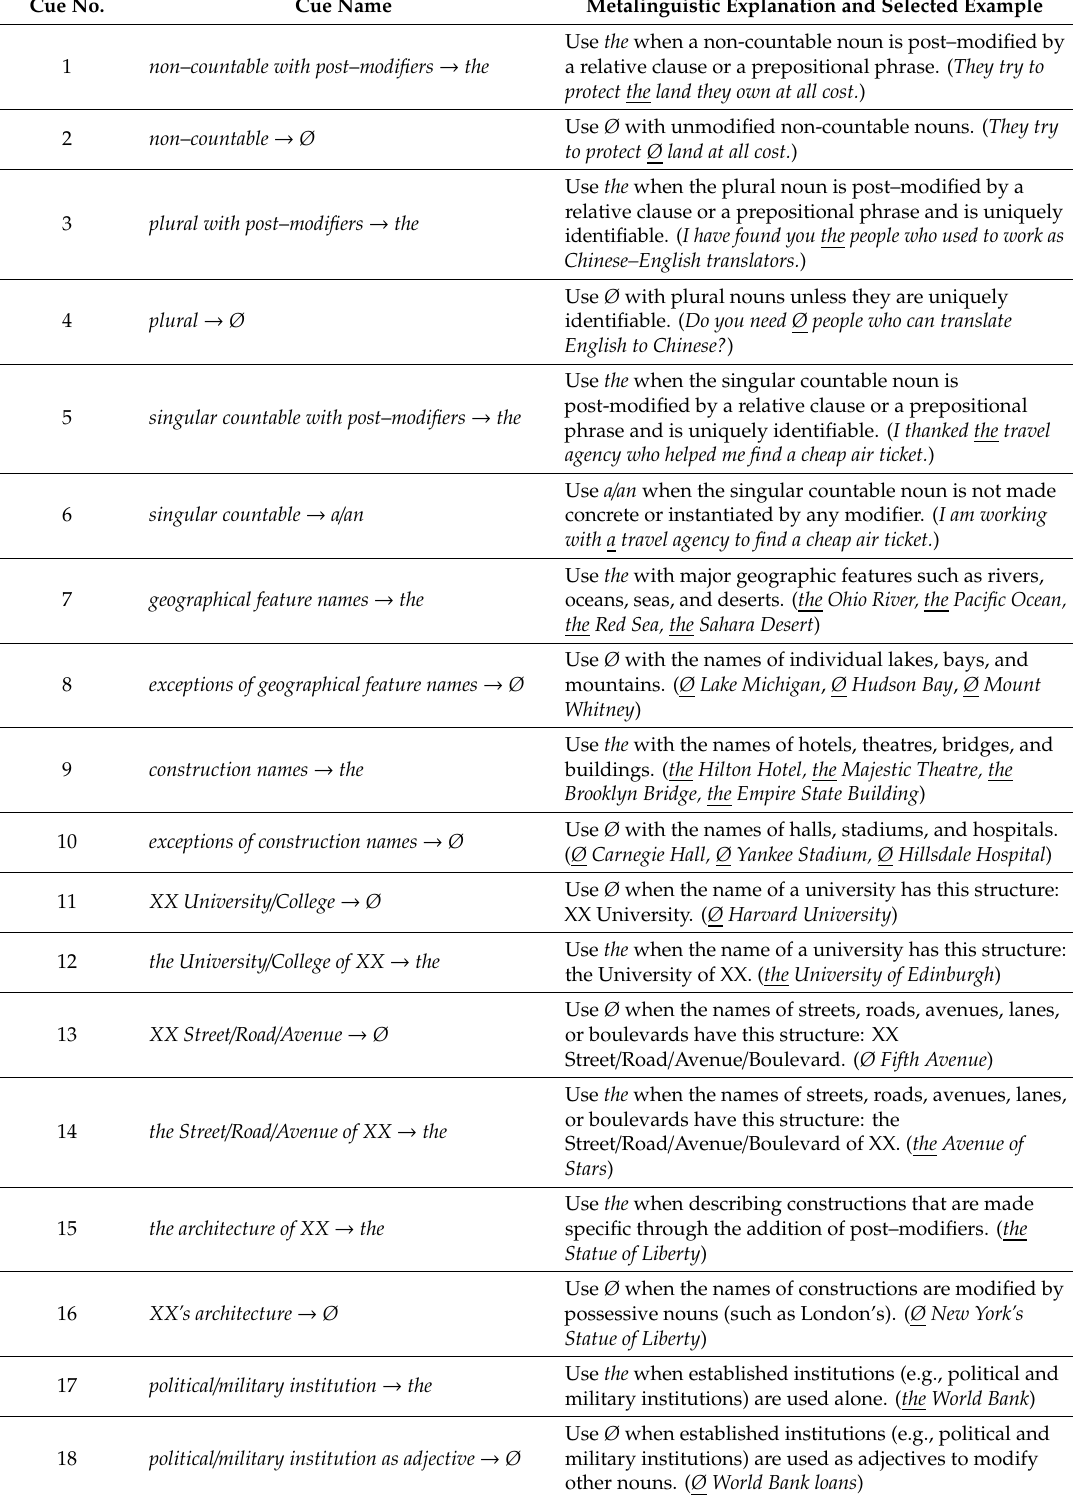
Table A1. Target article cues with metalinguistic explanations and exemplars. Cue